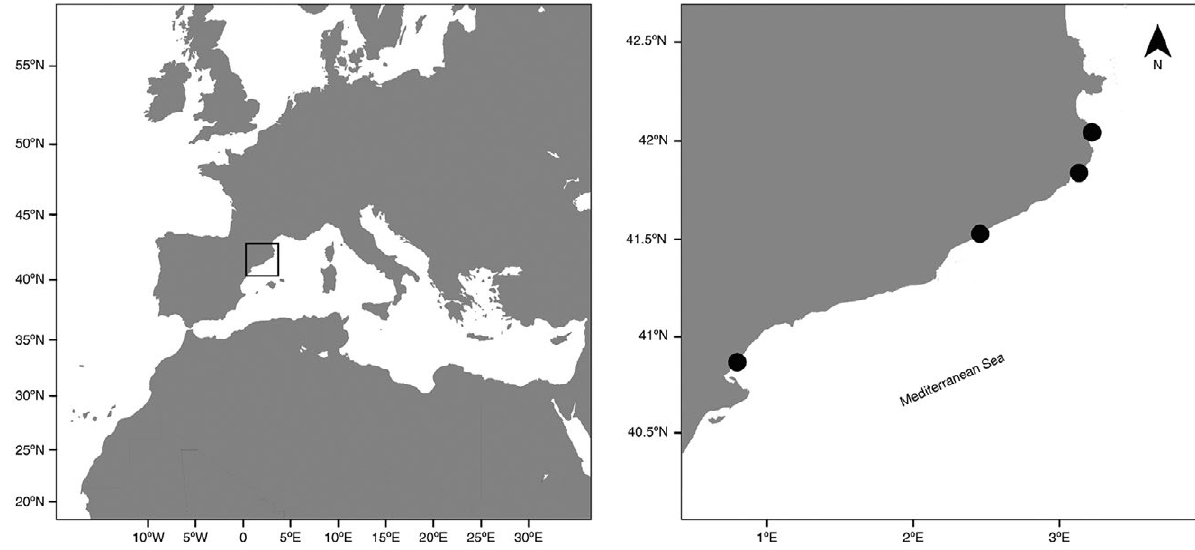
Fig. 1. – Study area and locations of free-diving underwater fish photography. A, Medes Islands; B, Palamós; C, Mataró; and D, Ametlla de